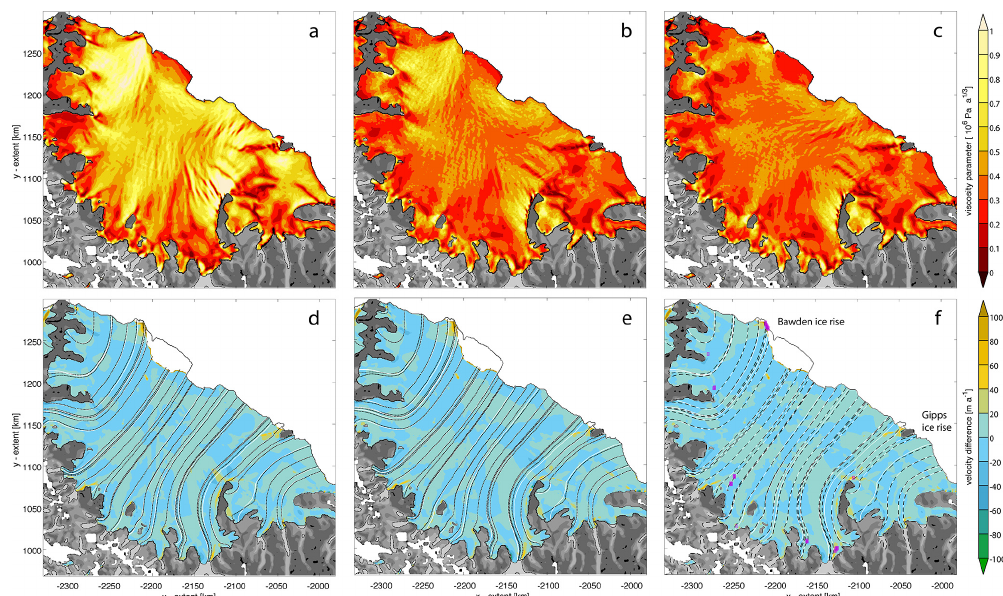
Figure 3. Ice viscosity parameter (a–c) as inferred by the control method for the Larsen C Ice Shelf. Velocity difference (d–f) as in Fig. 1. Panels (a, d) show results based on the actual Bedmap2 geometry, while panels (b, e) show results after flotation is guaranteed using the T method. Inversion results on Larsen C for the T geometry accounting for friction beneath pinning points not included in Bedmap2 (c, f) . Grey shading indicates observed velocity magnitude on grounded parts of the ice sheet. The Bedmap2 shelf extent is indicated by a black contour line. On the shelf, black dashed and white lines indicate observed and modelled streamlines respectively. The black dashed line on the grounded areas gives the 100ma − 1 isoline of the observed surface velocities. Locations of pinning points (PIN5) not in Bedmap2 are indicated with pink squares in panel (e)